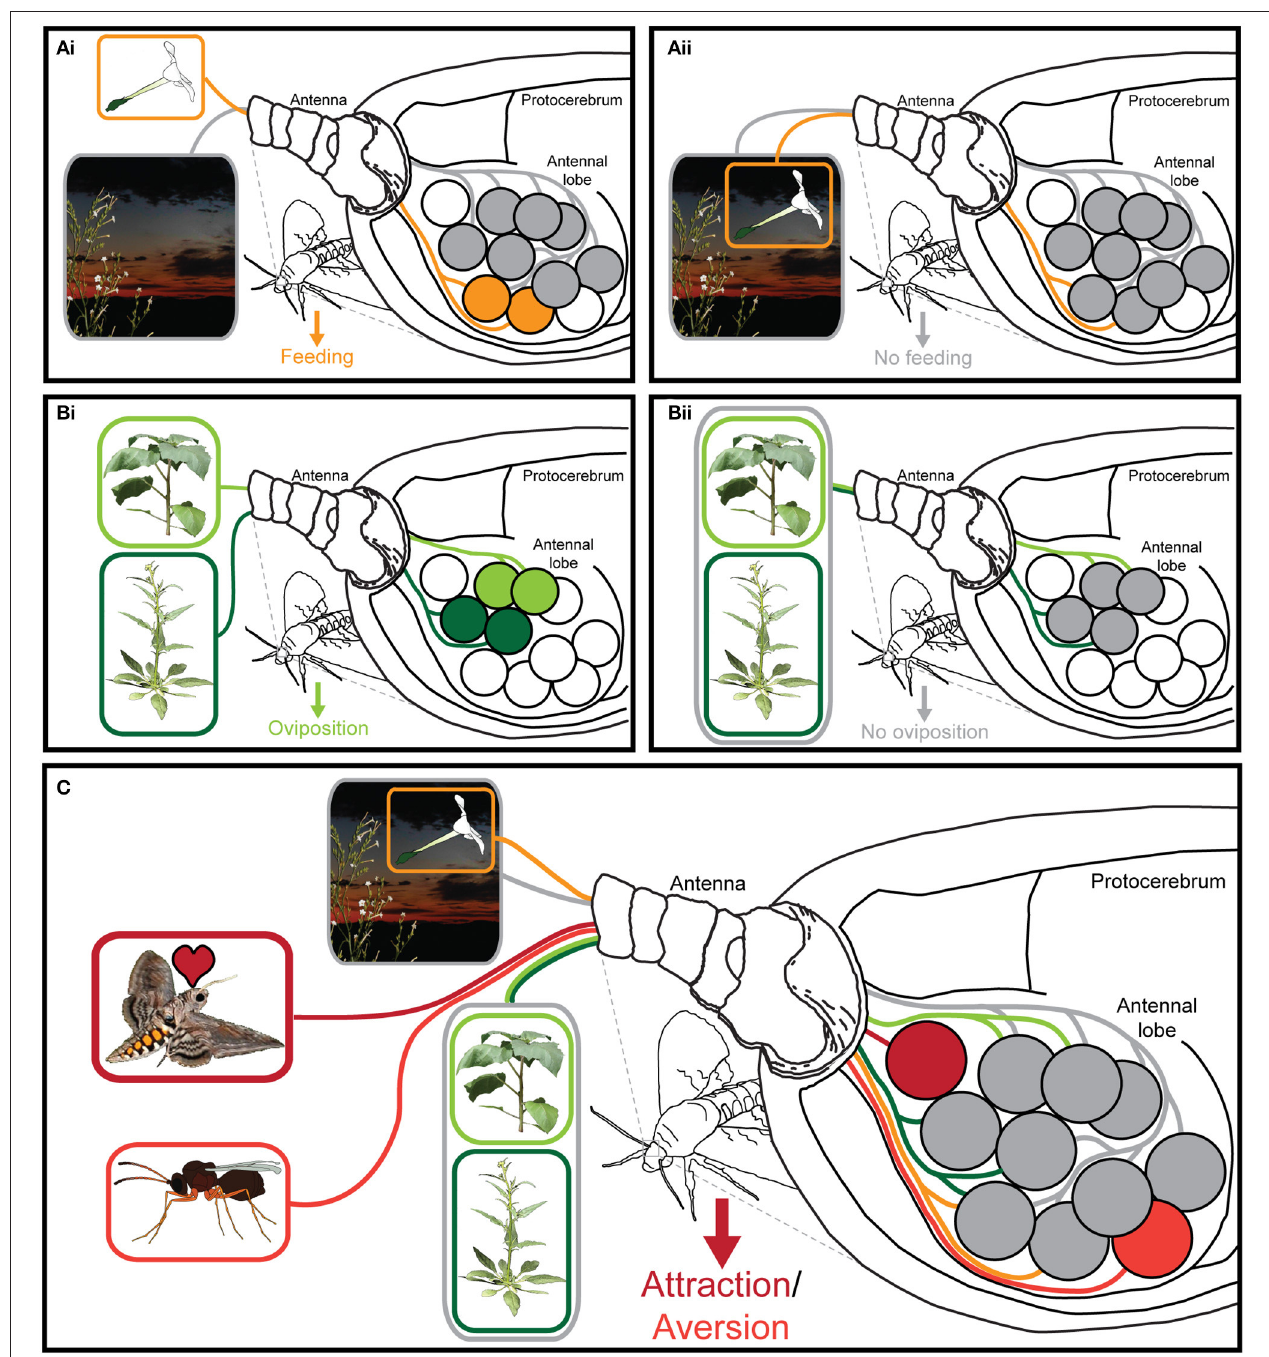
FIGURE 1 | Processing of olfactory information in the insect antennal lobe. (Ai) Insects can easily navigate toward an odor source (orange), in front of a chemically distinct odor background. (Aii) This navigation however becomes corrupted, when the same volatiles are present both in the background as well as in the odor source (gray) (Riffell et al., 2014). (Bi) When the odor blends of two different host plants were presented spatially separated, both were attractive to the female moth (green), but (Bii) when these two blends were mixed both spatially and temporally into a novel mixture, this new blend became meaningless or even repellent to the moth (gray) (Spaethe et al., 2013). (C) Ecologically labeled lines (red) are processed independently of background odors or other odor plumes present in the environment of the insect (Badeke et al., 2016).